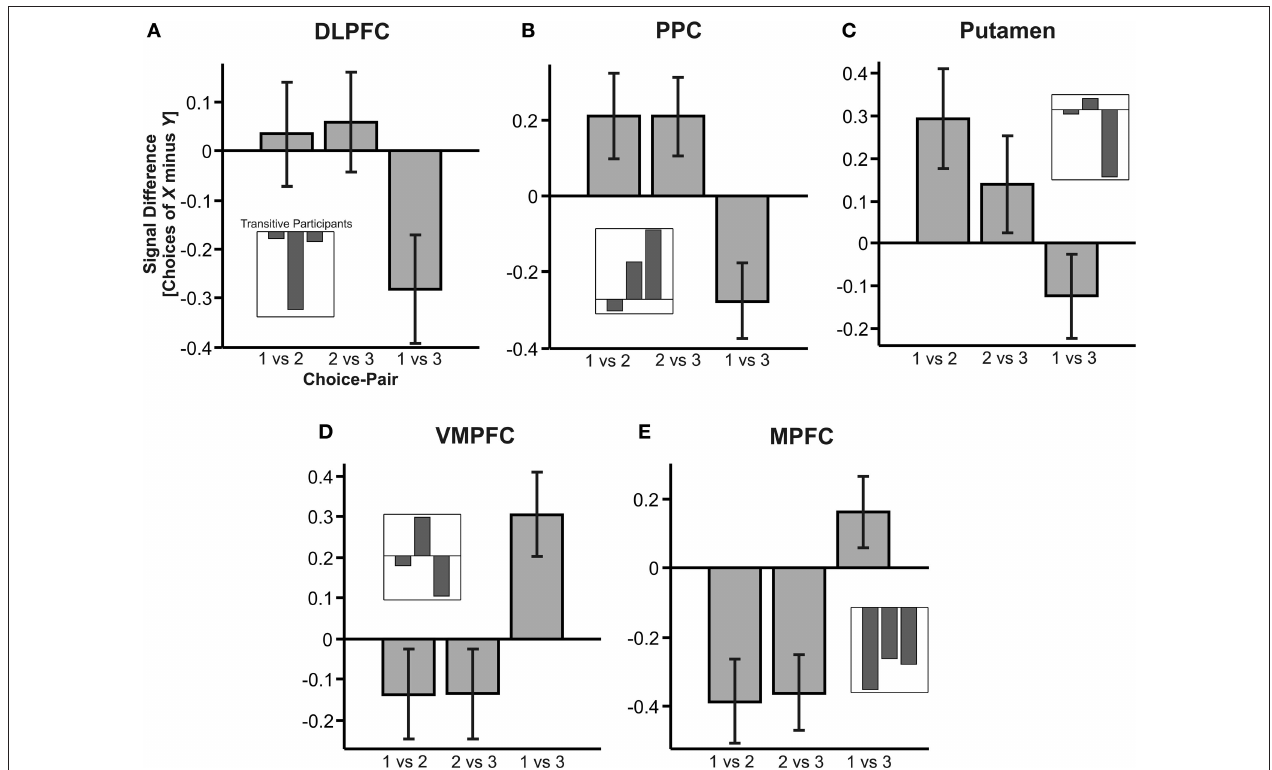
Figure 4 | Activation in desirability-coding brain structures. The graph shows mean activity ( ± SEM) in the regions shown in Figure 3 , averaged across all triplet gamble sets. The bars represent the difference in BOLD activation to choices of gamble x relative to choice of gamble y in gamble pair xy , i.e., how much more (or less) active a brain region was in response to choices of gamble x relative to choices of gamble y . Gamble numbers 1, 2 and 3 are placeholders for